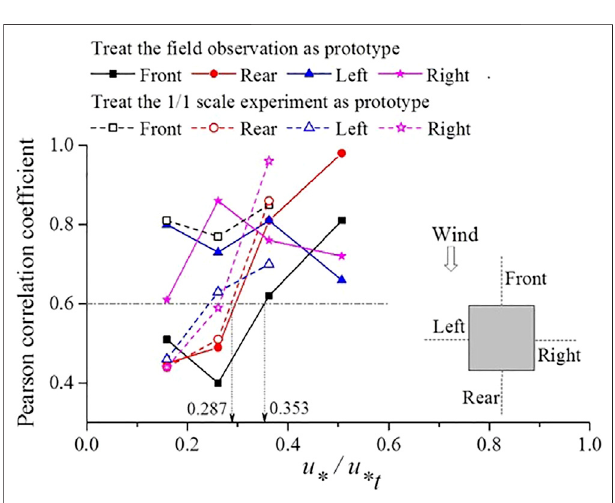
FIGURE 4 | Pearson correlation coef fi cients of the normalized snow depth between the prototype and scale